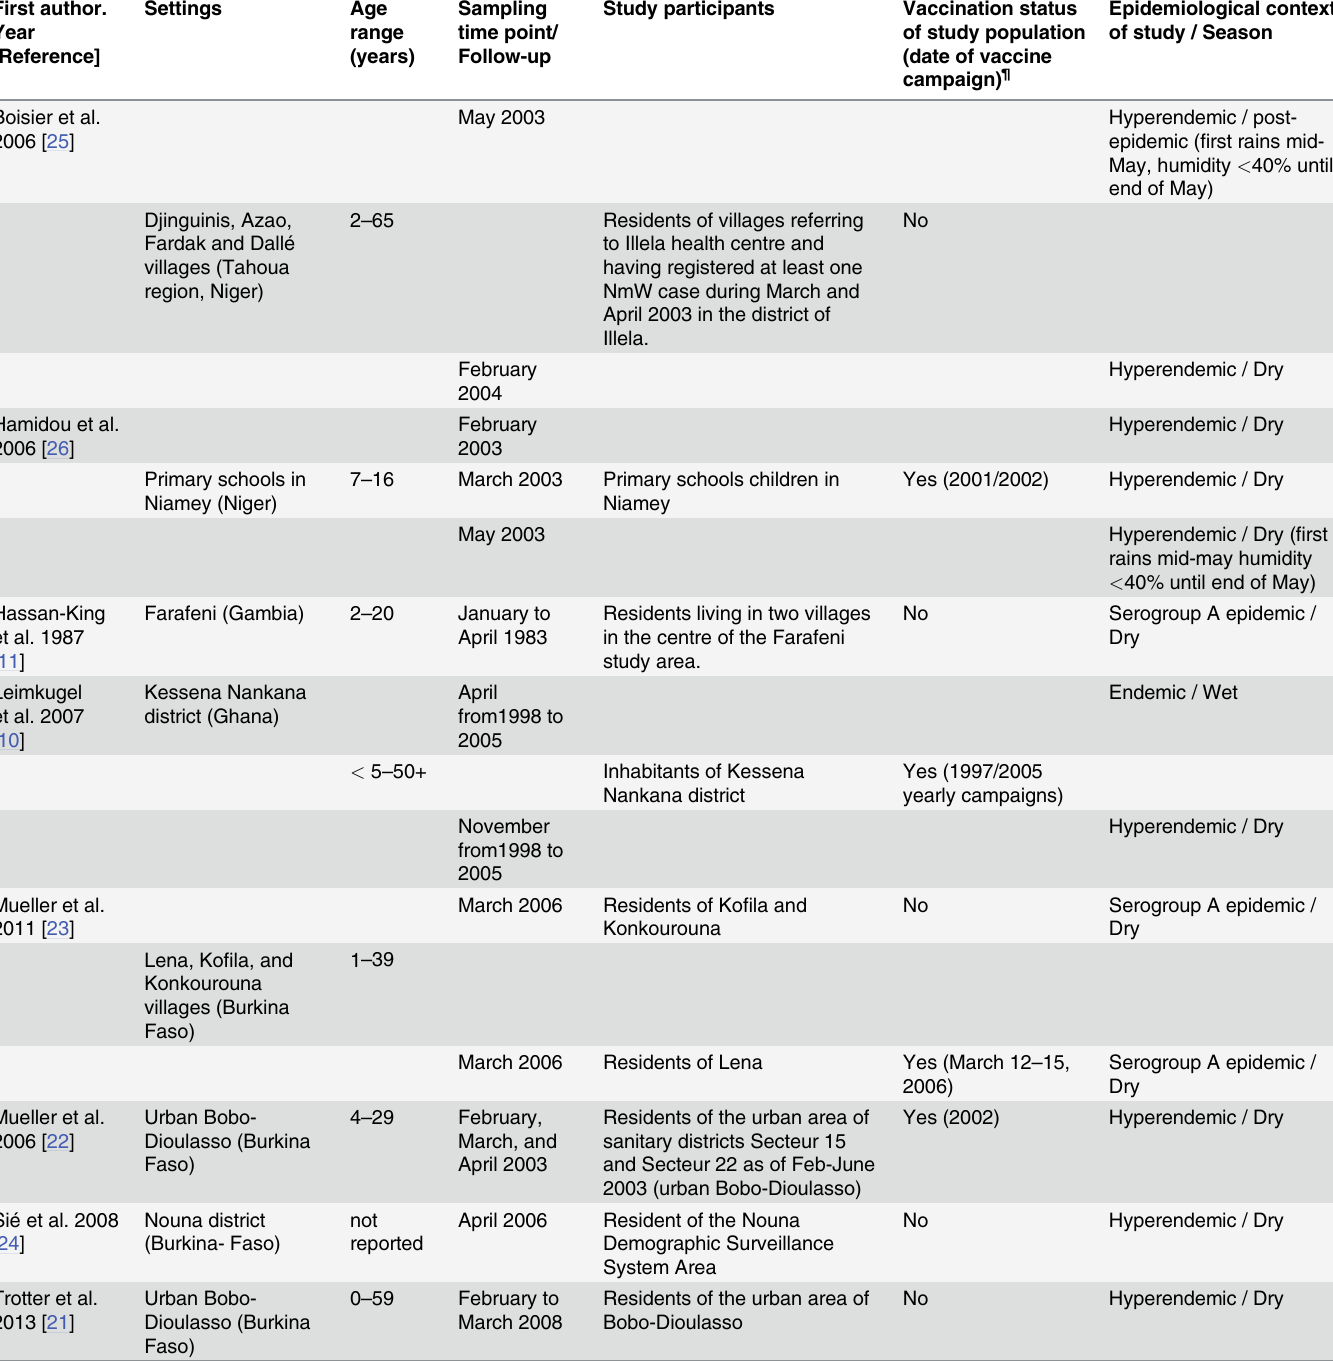
Table 1. Summary characteristics of included studies reporting meningococcal serogroup-speci fi c incidence and carriage prevalence of the same population and time